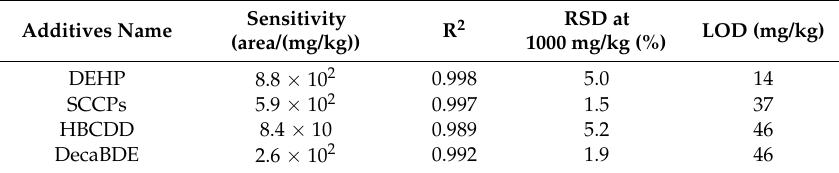
Table 2. Summary of sensitivity, correlation coefficient (R 2 ), and RSD.